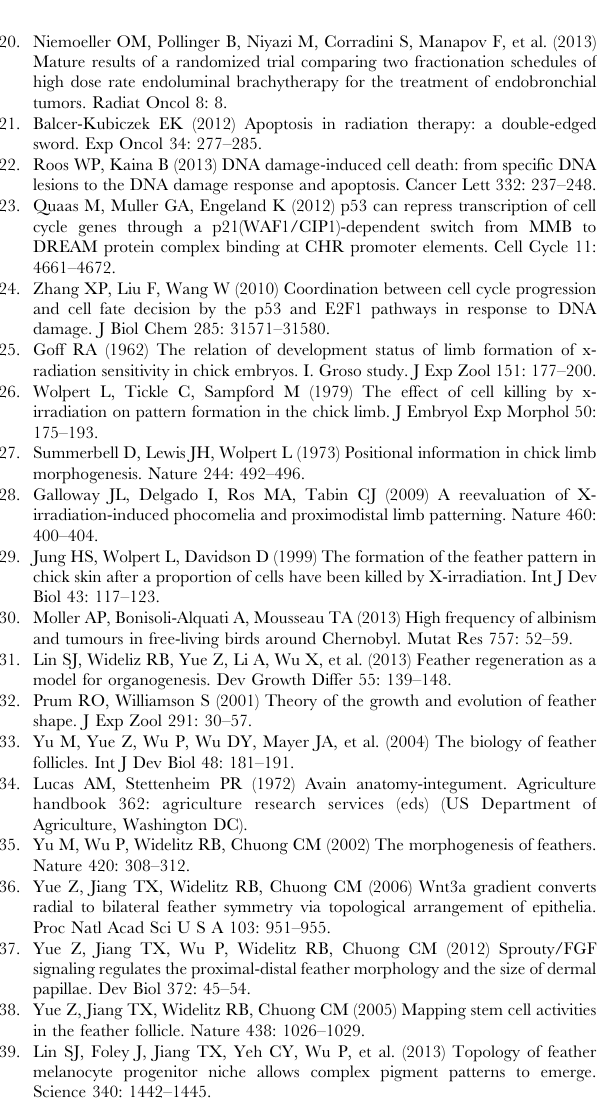
Figure S5 Specificity of AG-490 treatment in the feather follicles. (A–B) Western blot analysis; (C–D) RT-PCR analysis of the feather follicles after 20 Gy IR exposure, with or without AG- 490 rescue (5 mg/kg i.p. twice injection at T0 and T1).